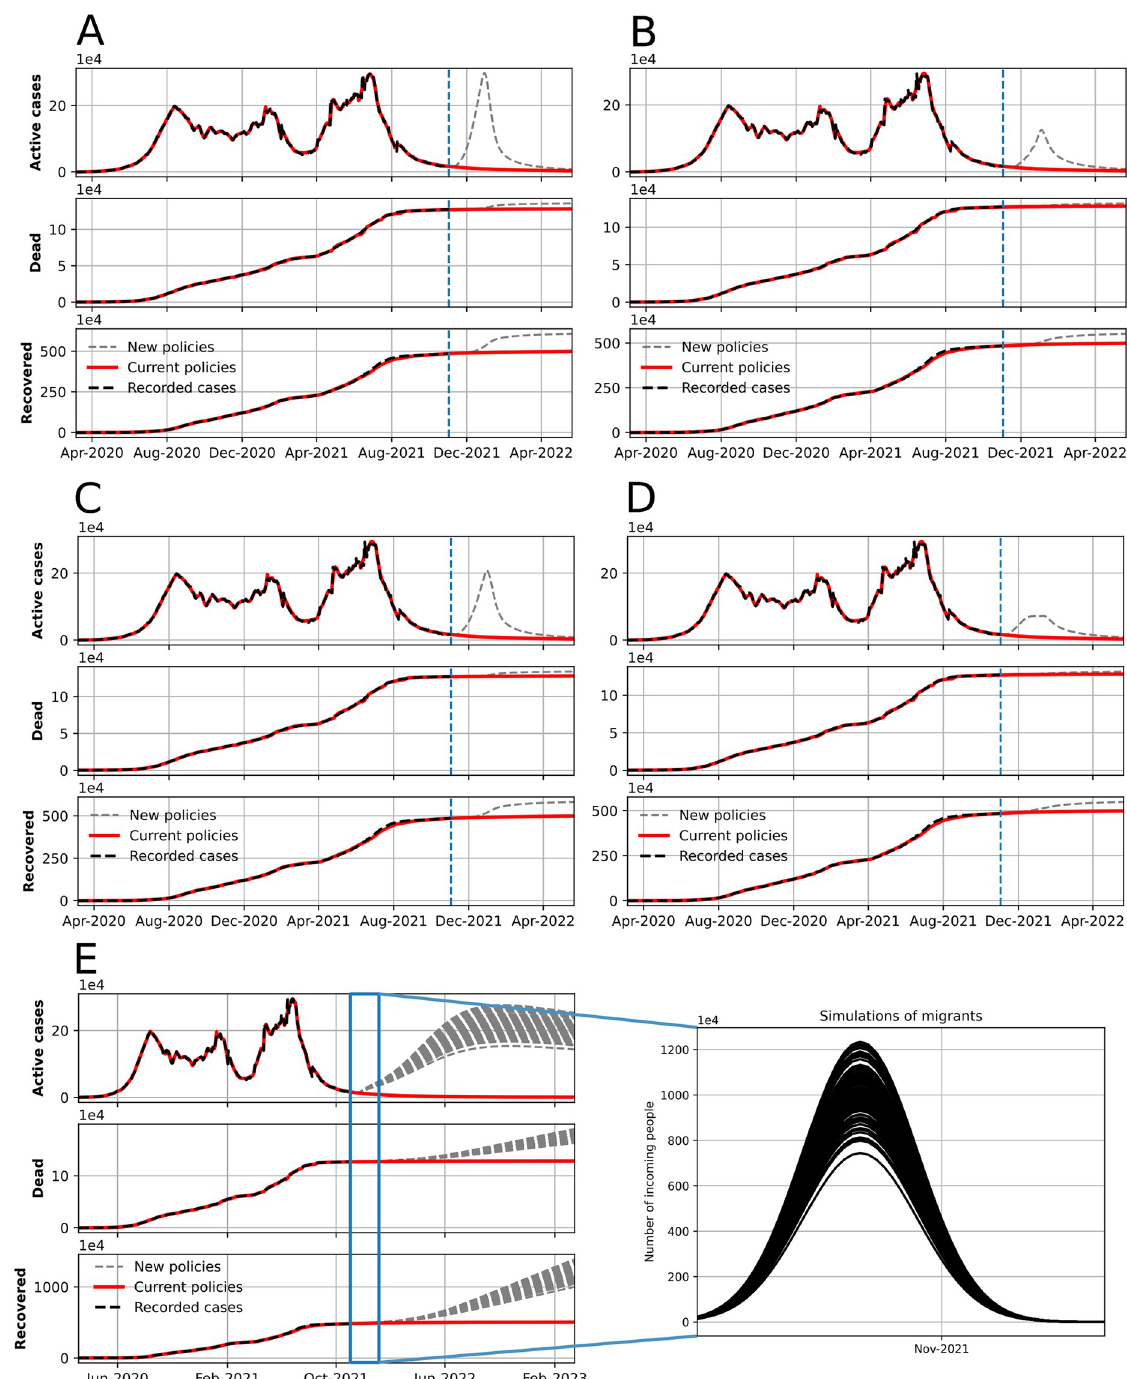
Fig 7. Model simulation using Colombia as example, the blue dotted line shows the limit of model fitting. After that line we present two scenarios, one in which the simulation follows the same trend and other one in which we change some parameters related to public policies. In scenario (A) we present a change in quarantine behavior ( λ qf from 0.17 to 0.33). In the following figures, we present the original scenario but adding some public policies as (B) intermittent lock-downs as pulse-series, (C) increasing identification programs ( λ 0.11 to 0.15, and ϑ P from 0.55 to 0.60), (D) reducing the connectivity inside the country ( ν from 35 to 150), and (E) a Montecarlo simulation of multiple migration processes hypothesized in November 2021.